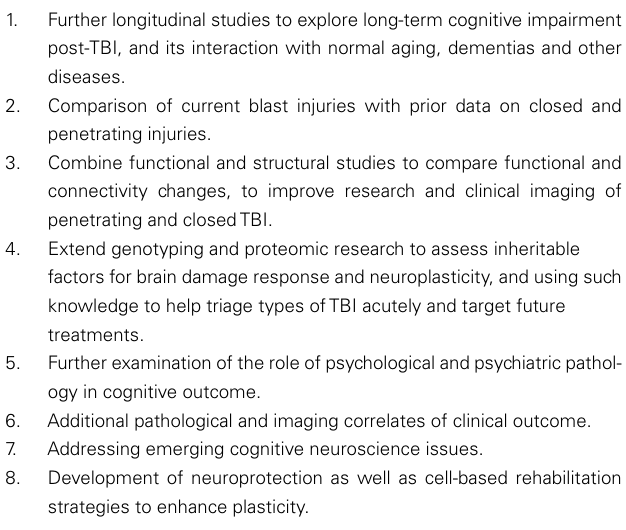
Table 2 | Possible future goals for studies of militaryTBI